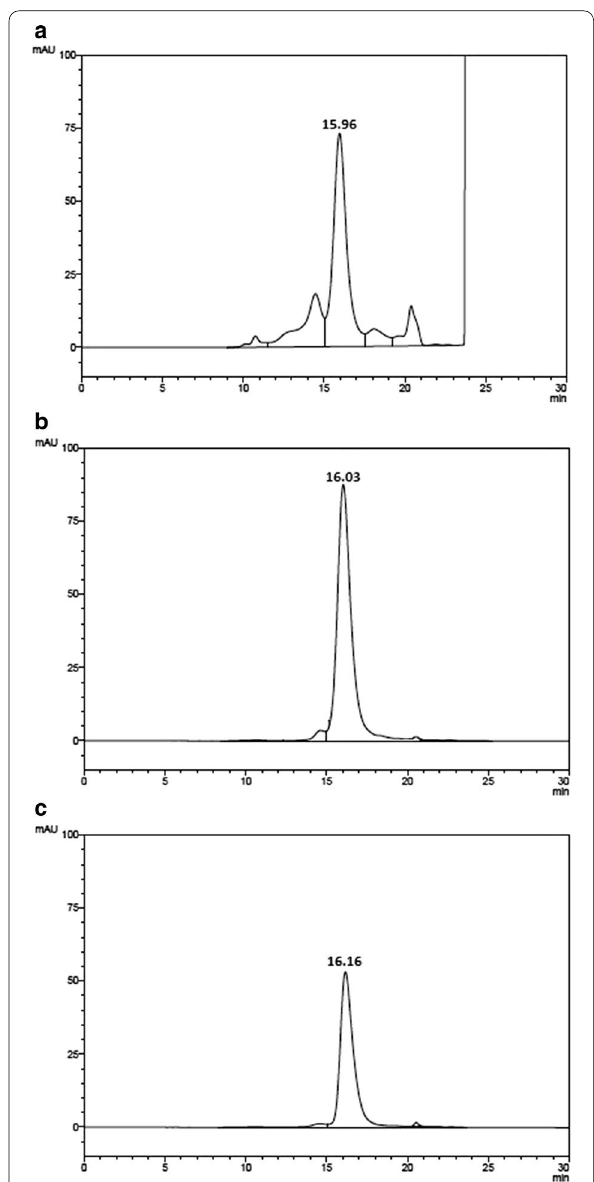
Fig. 6 HPSEC analysis of the pool of Δ 1-11 -G129R-hPRL collected from IMAC ( a ) and from SEC ( b ) and of the internal standard of hPRL ( c )